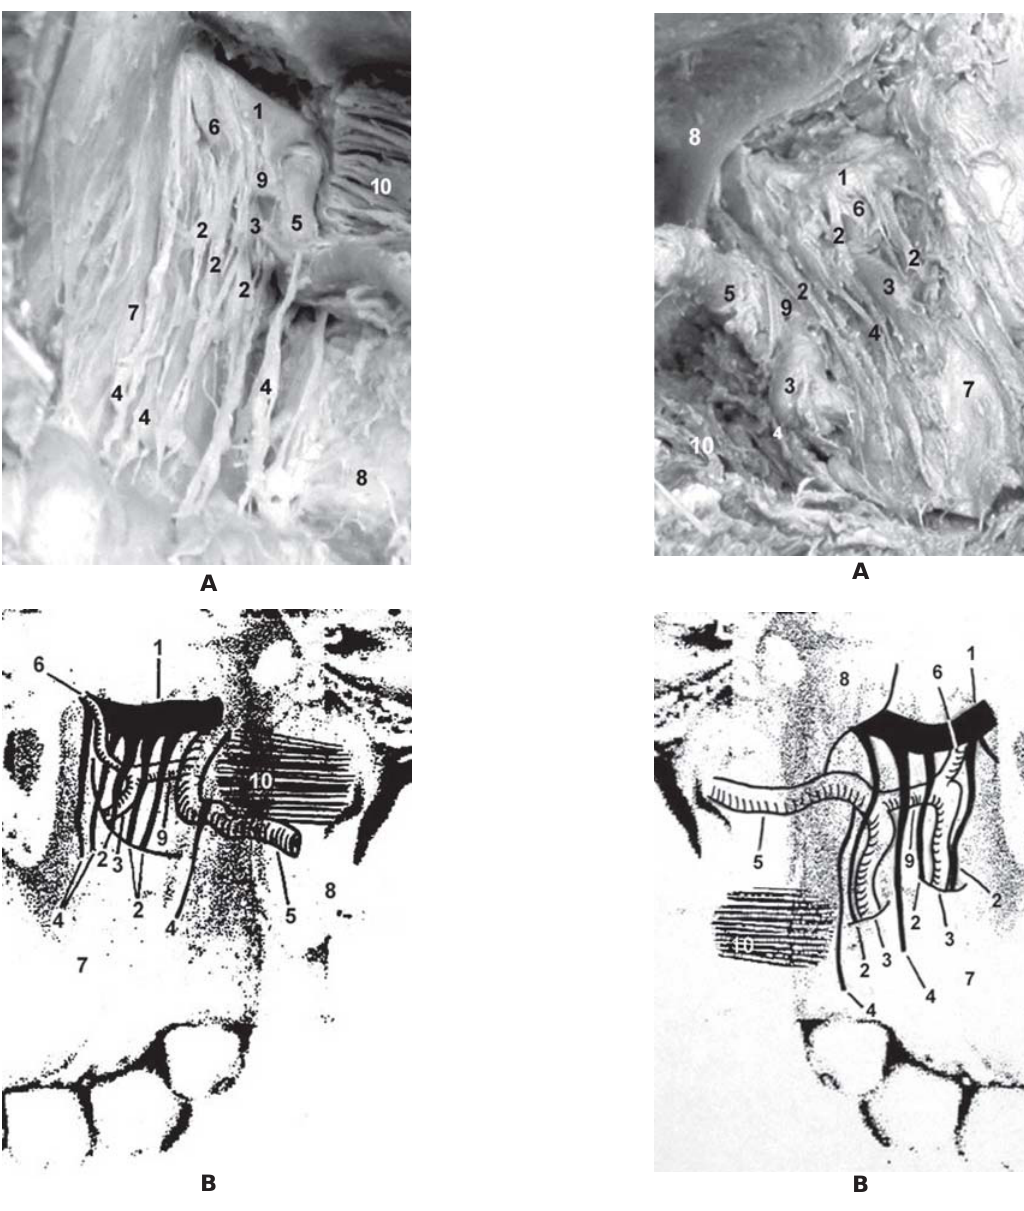
FIGURE 1- DISSECTIONS (A) AND SCHEMATIC DRAWINGS (B) OF THE ZYGOMATIC REGION, SHOWING TUBERAL DISTRIBUTION OF THE MAXILLARY NERVE AND ARTERY AND THEIR BRANCHES: 1.Maxillary nerve; 2. Posterior superior alveolar nerve; 3. Posterior superior alveolar artery (ASP); 4. Descendent nervous branches to the zygomatic region; 5. Maxillary artery; 6. Infraorbital artery (IO); 7. Maxillary tuberosity; 8. Lateral lamina of pterygoid process; 9. Arterial trunk (ASP/IO); 10. Lateral pterygoid